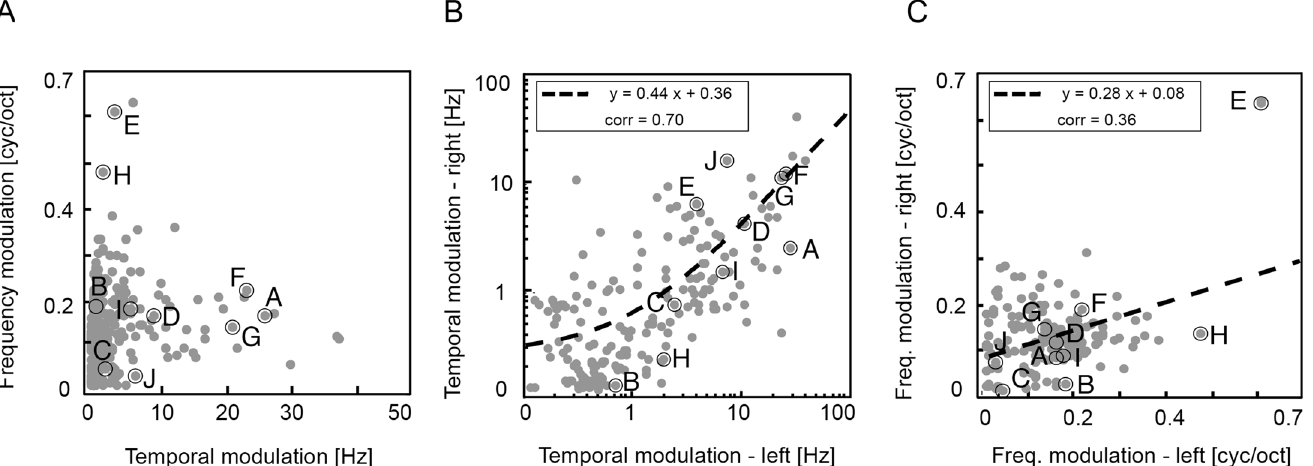
Fig 5. Spectrotemporal properties of the representation. A) Centers of mass of monaural modulation spectra. B) Centers of mass of temporal modulation in monaural parts of B i basis functions plotted C) Centers of mass of spectral modulation in monaural parts of B i basis functions plotted. Letters correspond to panels in Fig 4. Black dashed lines depict linear regression fits. Parameters of each fit are written in figure insets.